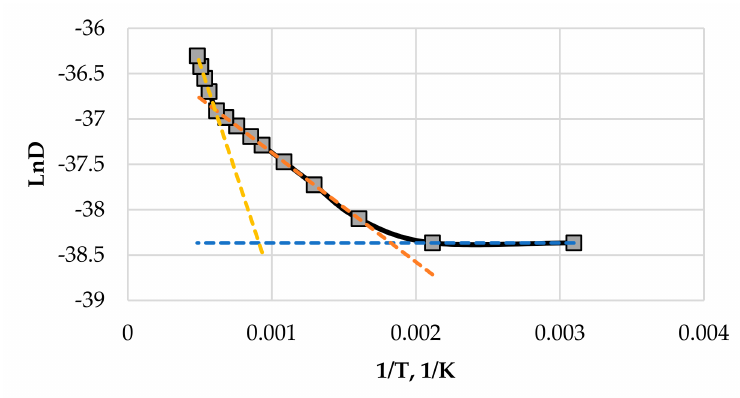
Figure 1. The dependence of di ff usion coe ffi cient on substrate temperature used in calculations.